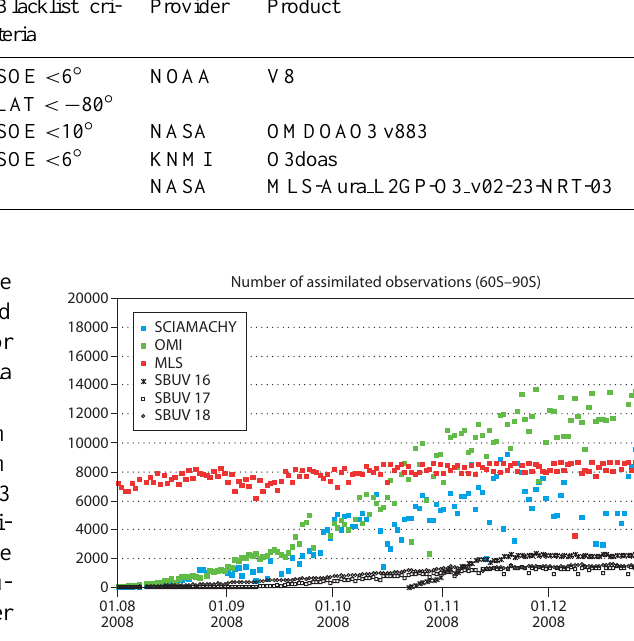
Table 1. Assimilated satellite observations, specifications and blacklist criteria with respect to solar elevation (SOE) and latitude (LAT). Sensor